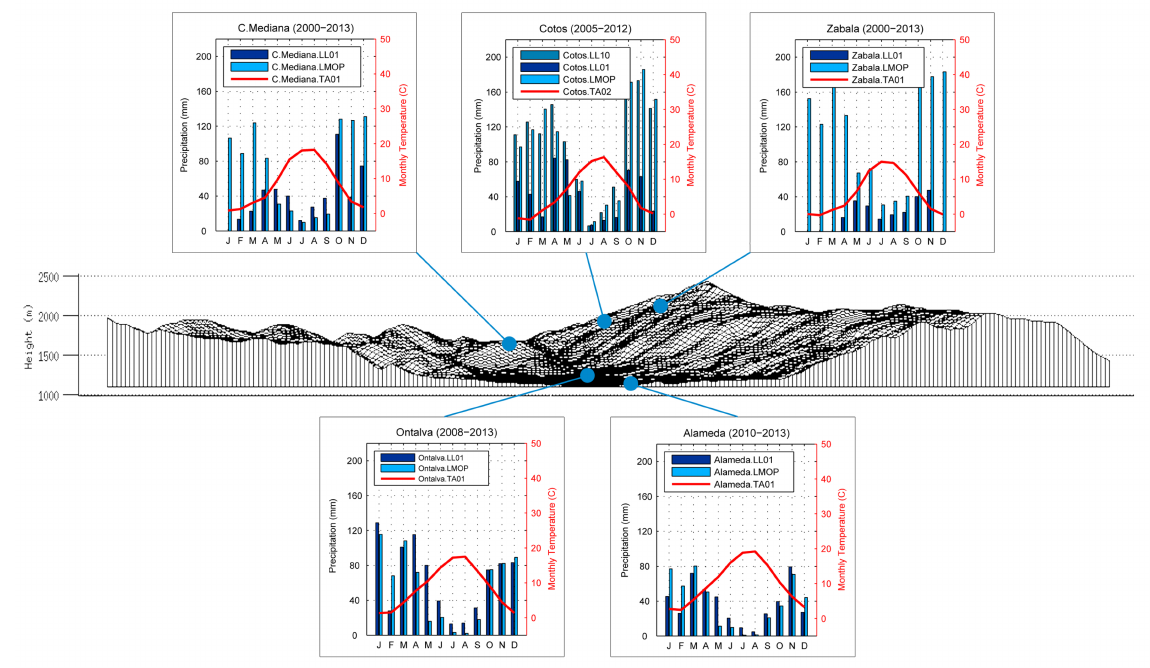
Figure 15. Mean monthly temperature (TA01, TA02) and precipitation observed (LL01, LL10) and modeled (LMOP) at all